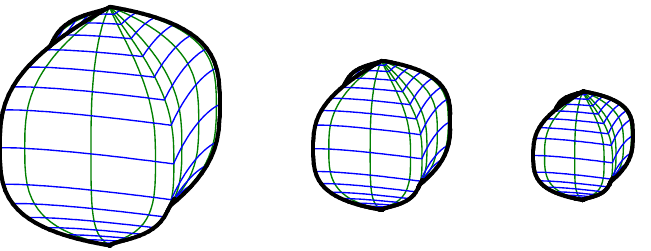
Figure 9. Entries of the diagonal matrix A equal to 0.5 ( left ), 0.8 ( middle ), and 1.1 ( right